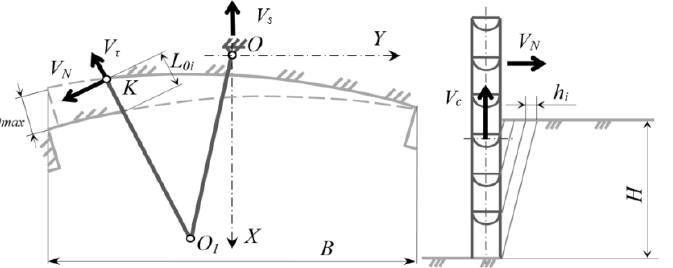
Figure 6. Calculation scheme for determining the resistance to digging the soil by the side faces of the rotor buckets.